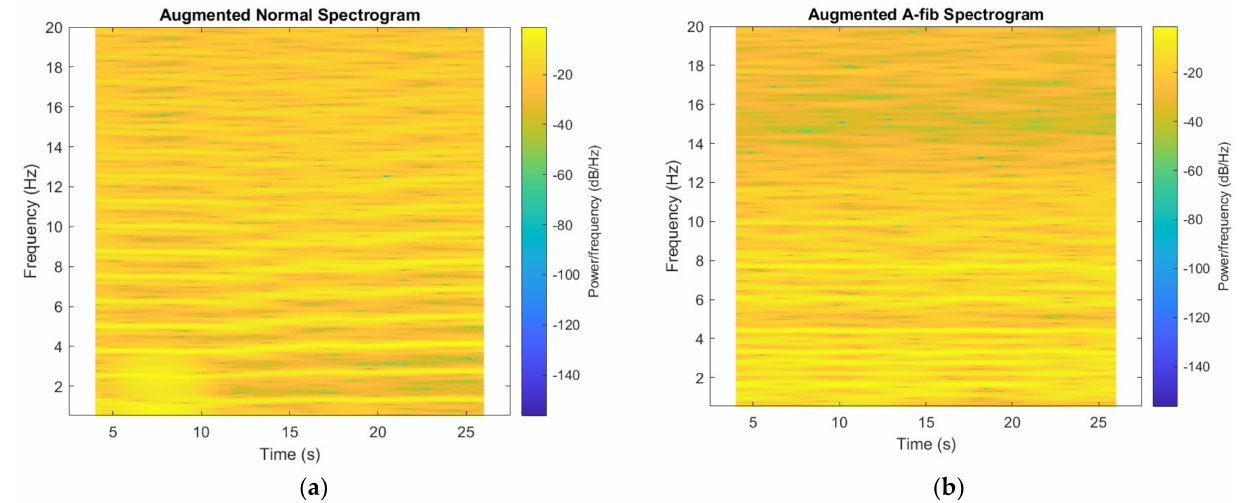
Figure 5. Augmented spectrograms obtained from ( a ) a normal sample; ( b ) an A-fib sample.